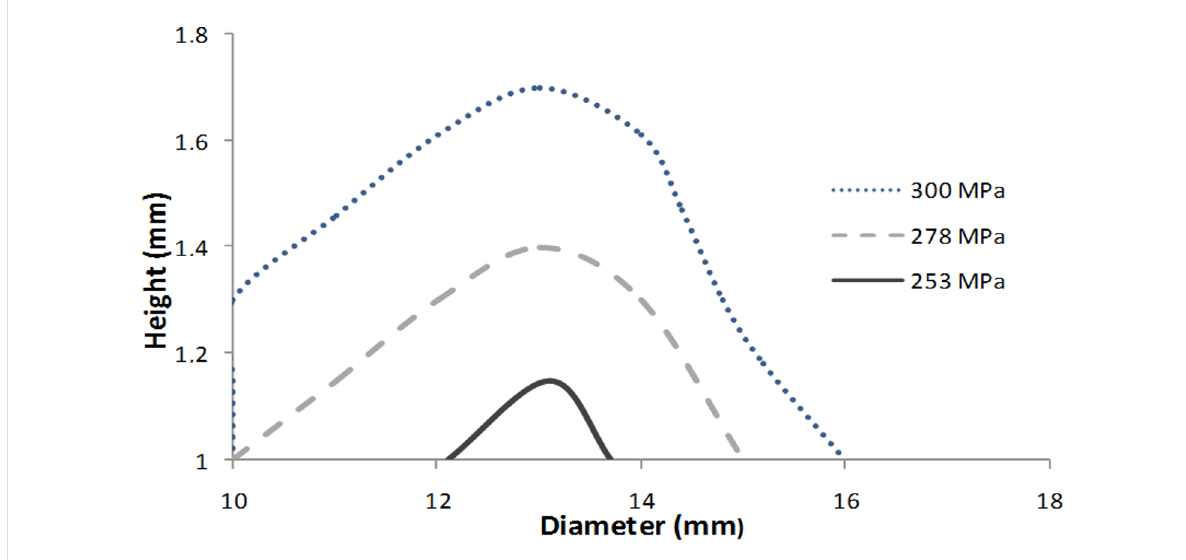
Figure 9: Pellet size and applied pressure for the best mechanical properties; scenario 1 (red square in Figure 8) is the selection of the best pellets with Y ≥ 90 MPa and Z ≥ 1.2 MPa.